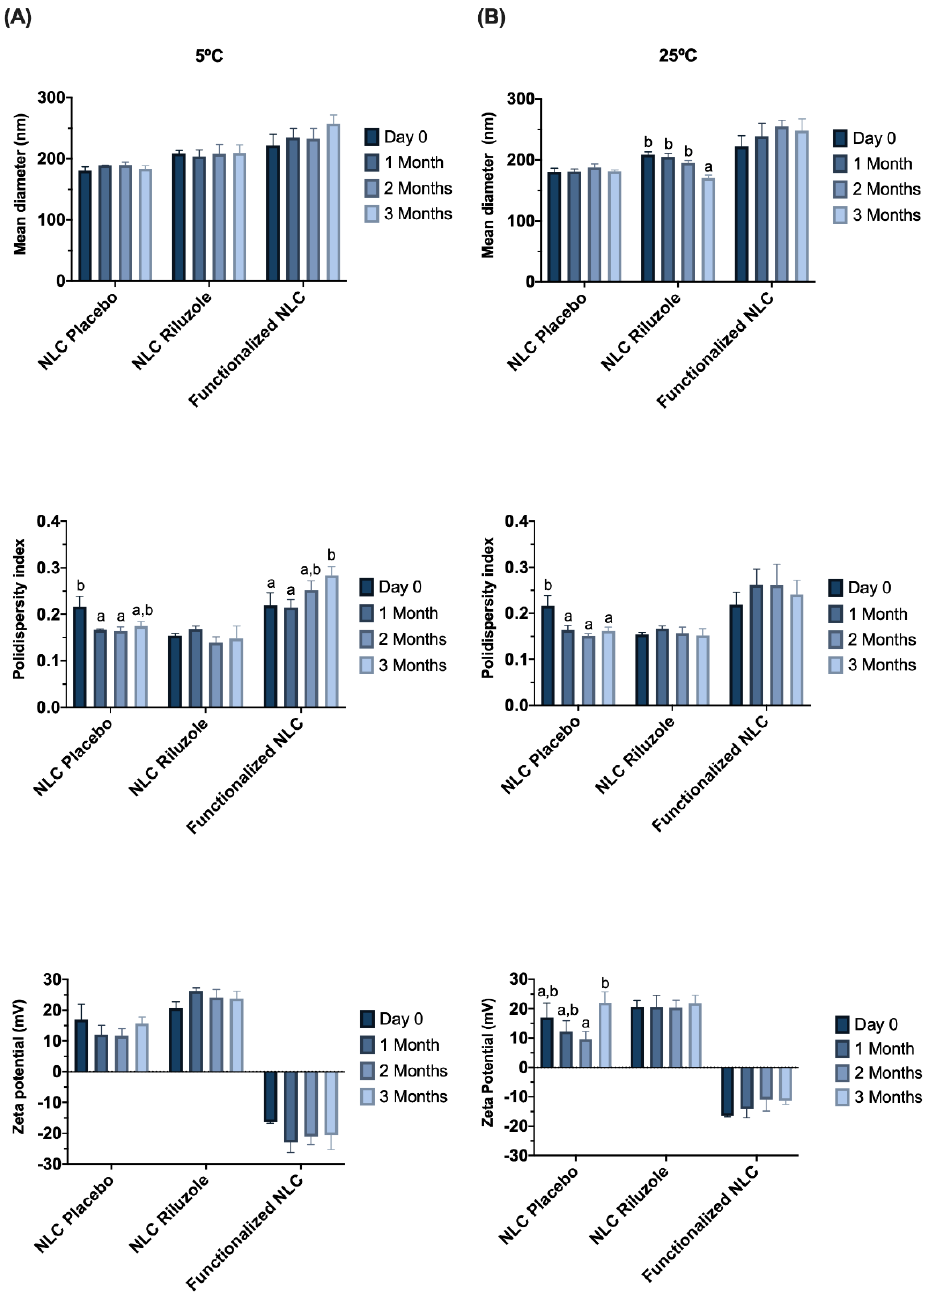
Figure 1. Effect of storage time on particle size, PDI, and zeta potential for NLC Placebo, NLC Riluzole, and functionalized NLC over 3 months at 5 °C ( A ) and 25 °C ( B ). Values are expressed as the mean ± SD ( n = 3). Data were analyzed using Tukey’s HSD test, with different letters (a,b) representing statistically significant differences ( p < 0.05) for the same formulation at different time points.